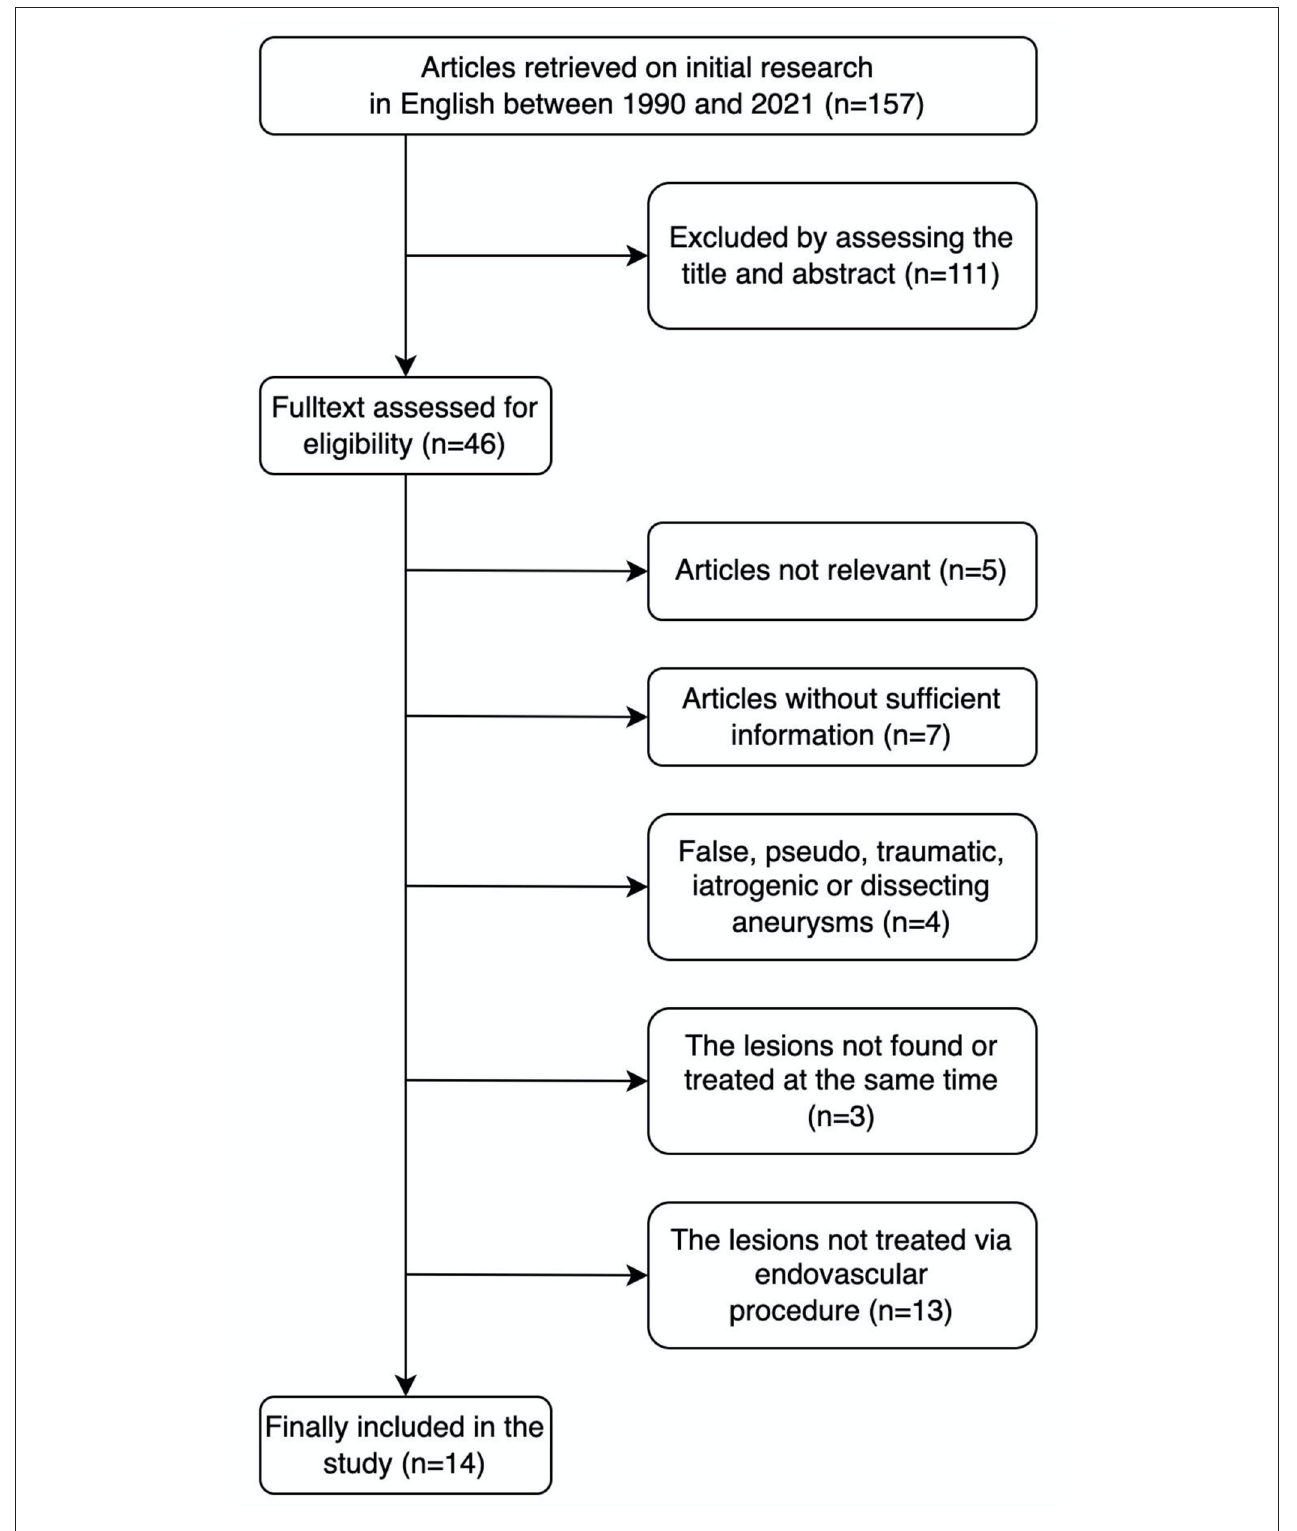
FIGURE 1 | A flowchart of the literature-selection process.